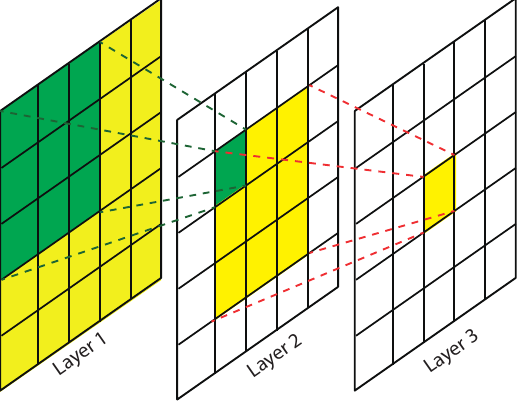
Figure 4. The receptive field of each convolution layer with a 3 × 3 kernel. The green area marks the receptive field of one pixel in Layer 2, and the yellow area marks the receptive field of one pixel in Layer